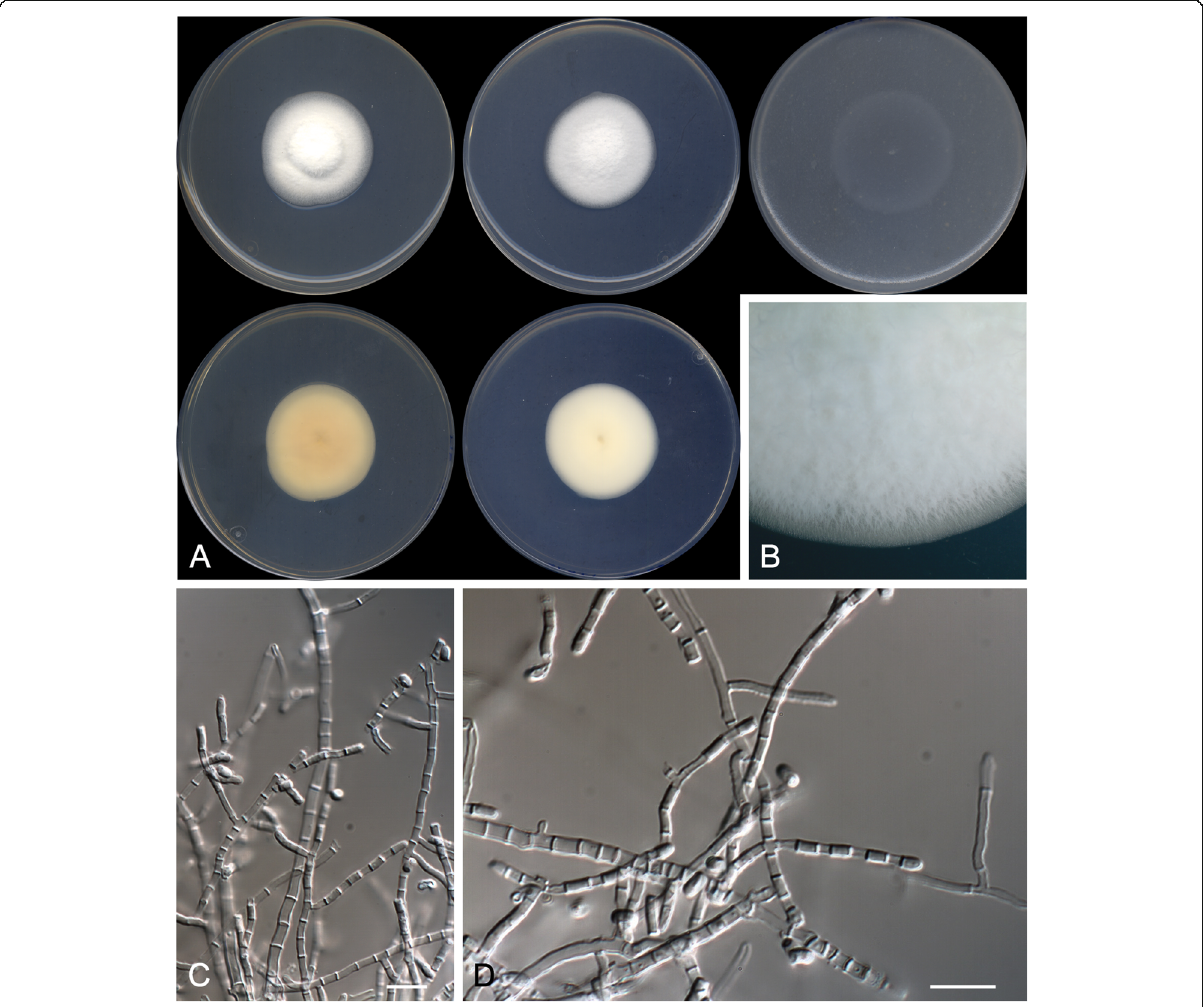
Fig. 7 Malbranchea multiseptata CBS 146931 T . a Colonies on PYE, PDA and OA after 14 d at 25 °C, from left to right (top row, surface; bottom row, reverse). b Detail of the colony on PDA. c – d Highly septate fertile hyphae and arthroconidia. Scale bar = 10 μ